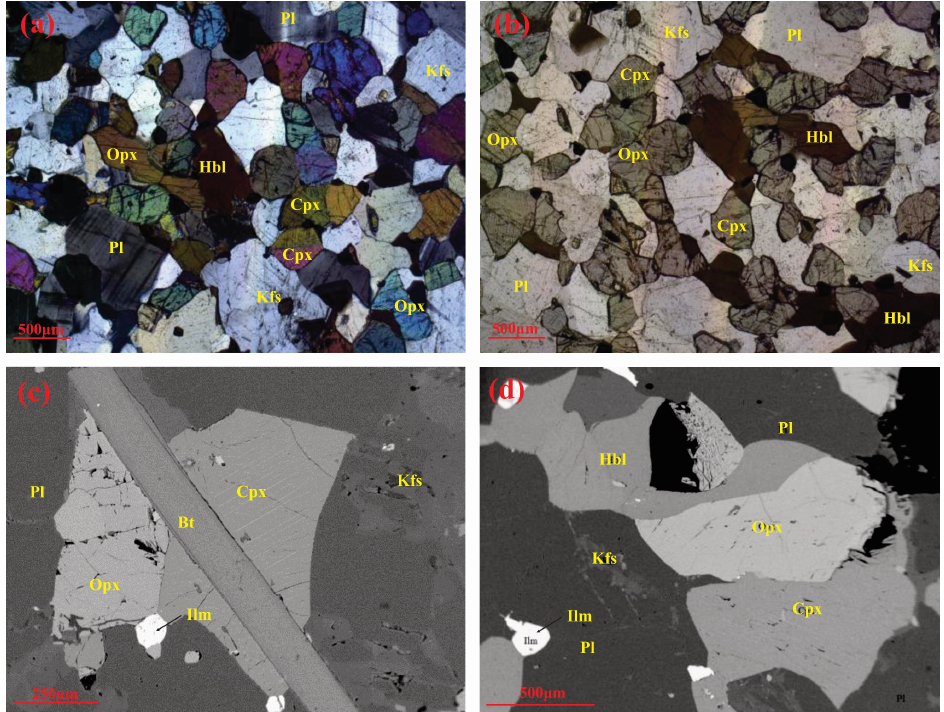
Figure 4. ( a , b ) Photomicrographs illustrating major mineral assemblages in gabbros; ( c ) Biotite cross-cutting orthopyroxene and clinopyroxene; ( d ) Crystals and blebs of K-feldspar within plagioclase associated with orthopyroxene and clinopyroxene.